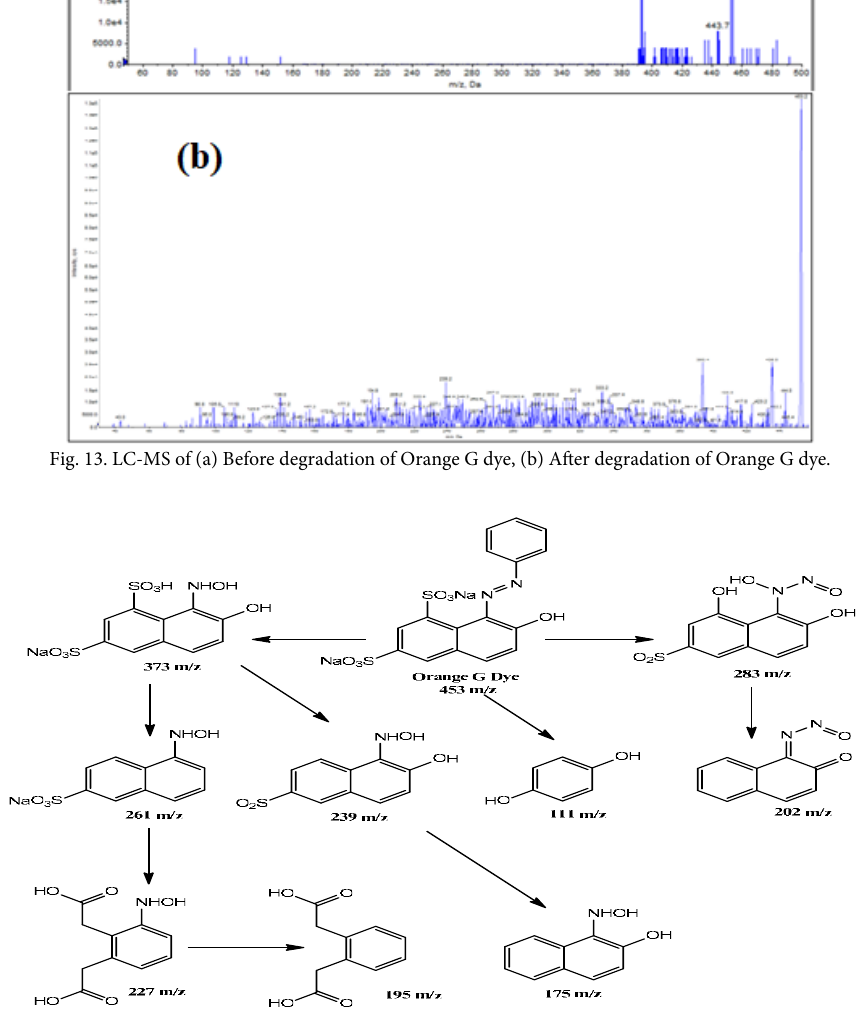
Fig. 14. Degradation mechanism of Orange G